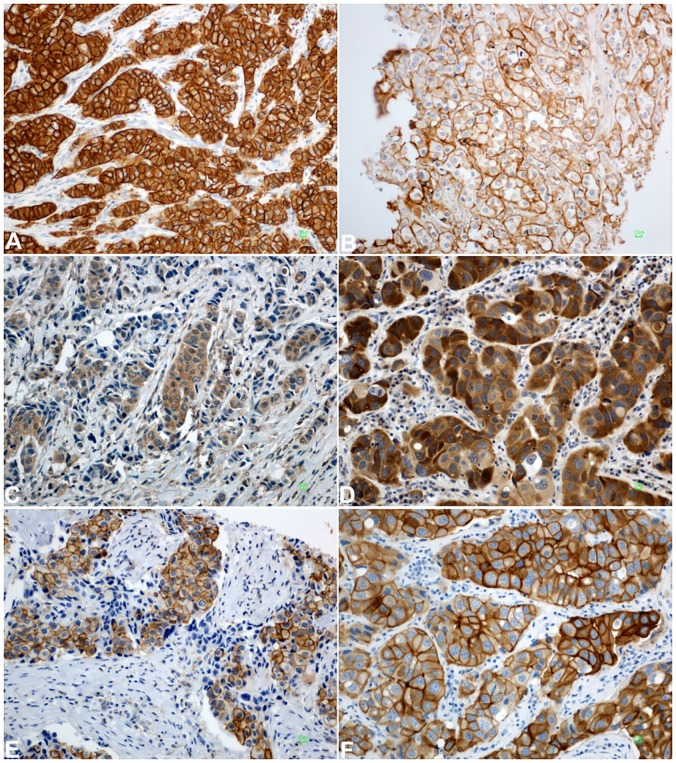
Representative staining images of proteins studied in invasive breast carcinomas.A. EGFR expression detected as moderate (2+) and strong (3+) membranous staining in neoplastic cells. B. Uniform, intense HER2 membranous staining (3+) in the majority of tumor cells. C. Moderate cytoplasmic HER3 expression in tumor cells. D. Moderate (2+) and strong (3+) cytoplasmic HER4 expression. E. Cytoplasmic and membranous expression of pHER2Tyr1221/1222. F. Strong (3+) membranous and moderate (2+) cytoplasmic staining of tumor cells for pHER2Tyr877. Bar: 10 μm. Magnification: x200.